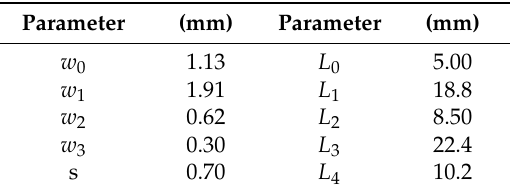
Figure 3. Detailed schematic of designed circuits: ( a ) The six-port sensor; ( b ) The six-port receiver; ( c ) The duplexer at sensor node including frequency doubler; ( d ) The dual band antenna. Table 1. Six-Port Sensor and Demodulator